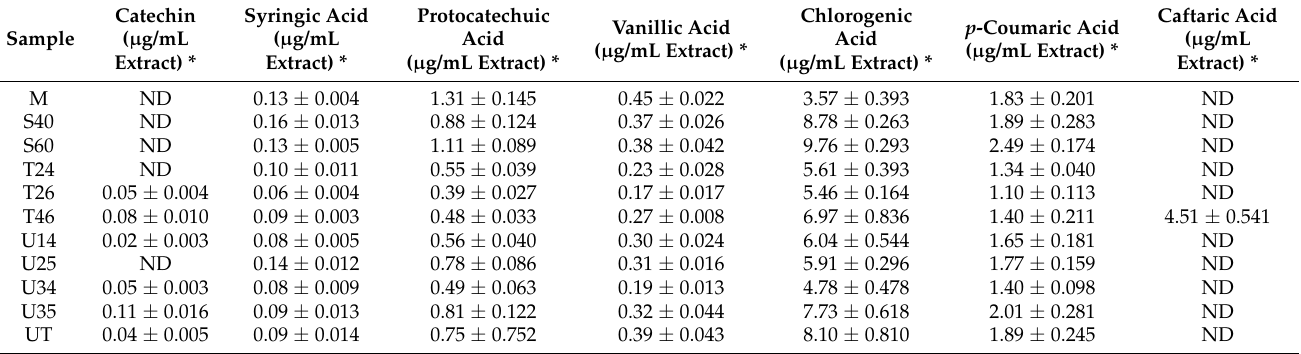
Table 4. Polyphenolic compounds in the selected